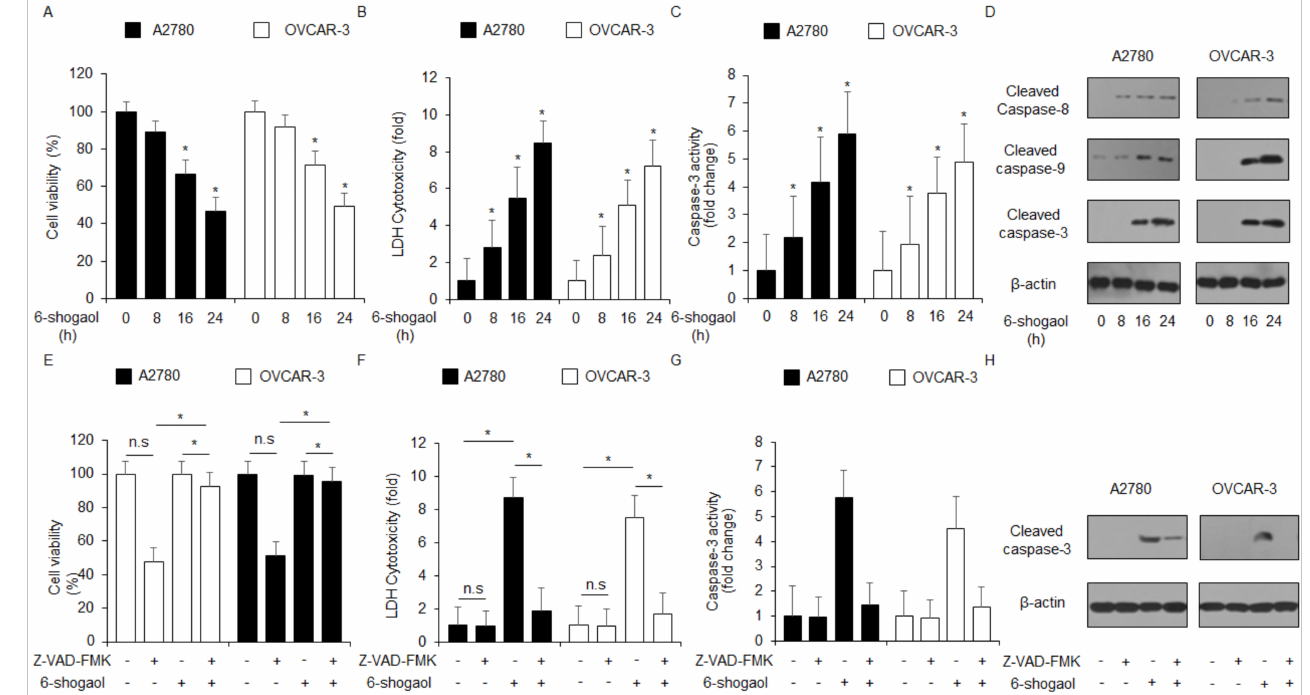
Figure 2. Anti-cancer effects of 6-shogaol in ovarian cancer cell lines in time-dependent manner. ( A – D ) 6-shogaol is Table 0. 16, and 24 h; 30 µ M) and the WST-1 assay, LDH assay, and caspase-3 activity assays were performed. Western blotting analyses of cleaved caspase-3, -8, and -9 for the indicated times in 6-shogaol-treated A2780 and OVCAR-3 cells; *, p < 0.05. β -actin was used as a protein loading control. ( E – H ) The effect of Z-VAD-FMK (50 µ M) and 6-shogaol treatment. A2780 and OVCAR-3 cells were pretreated with Z-VAD-FMK for 4 h and were subsequently treated with 6-shogaol (30 µ M, 24 h). Cell viability was determined using the WST-1 assay; cell cytotoxicity was monitored using the LDH assay, and caspase-3 activity was assessed using the caspase-3 activity assay; *, p < 0.05. n.s = not significant. To identify caspase-3 cleavage, a Western blot assay was performed. β -actin was used as a protein loading